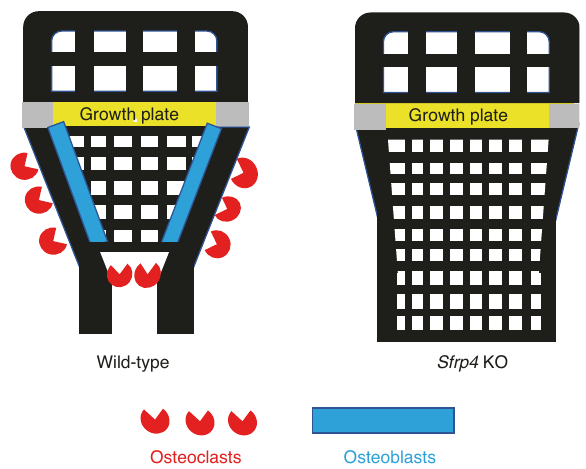
Fig. 6 Model of SFRP4 Actions on Metaphyseal Bone Development. Mineralized bone isshown in black; the growth plate is shown in yellow; and gray regions indicate theperichondrium. Wide meta- physes (Erlenmeyer fl ask deformity) result from reduced bone- resorption by periosteal osteoclasts. Reduced endocortical bone formation contributes to lowcortical bone thickness. We propose the abnormal persistence of diaphyseal trabeculae results from failure of osteoclastic resorption of these trabeculae near the metaphyseal - diaphyseal junction. Bone length is unaffected, indicating normal endochondral growth plate